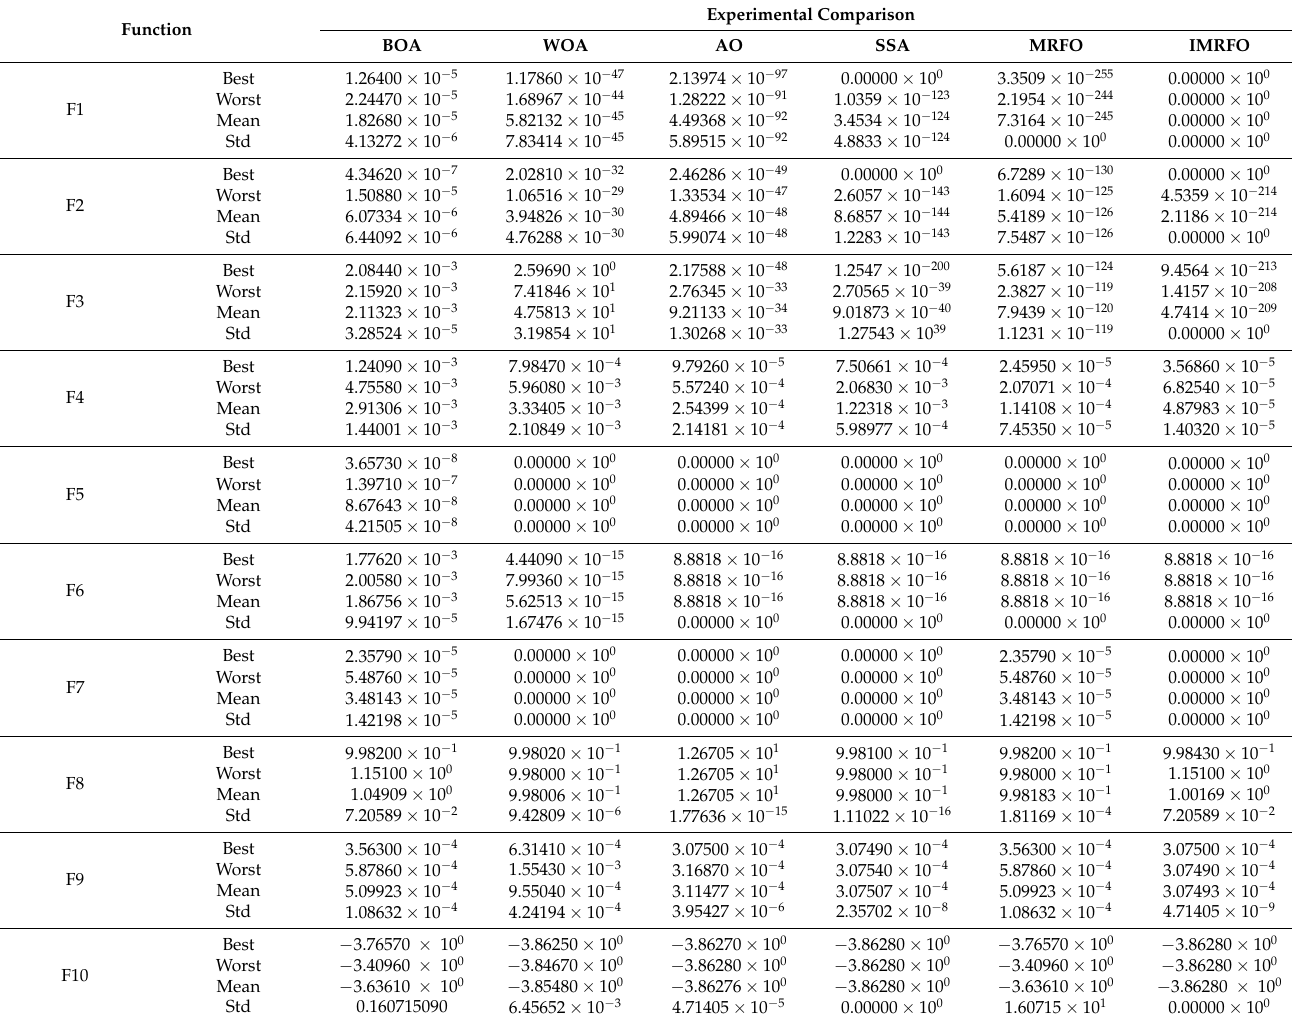
Table 7. Optimization search results of various